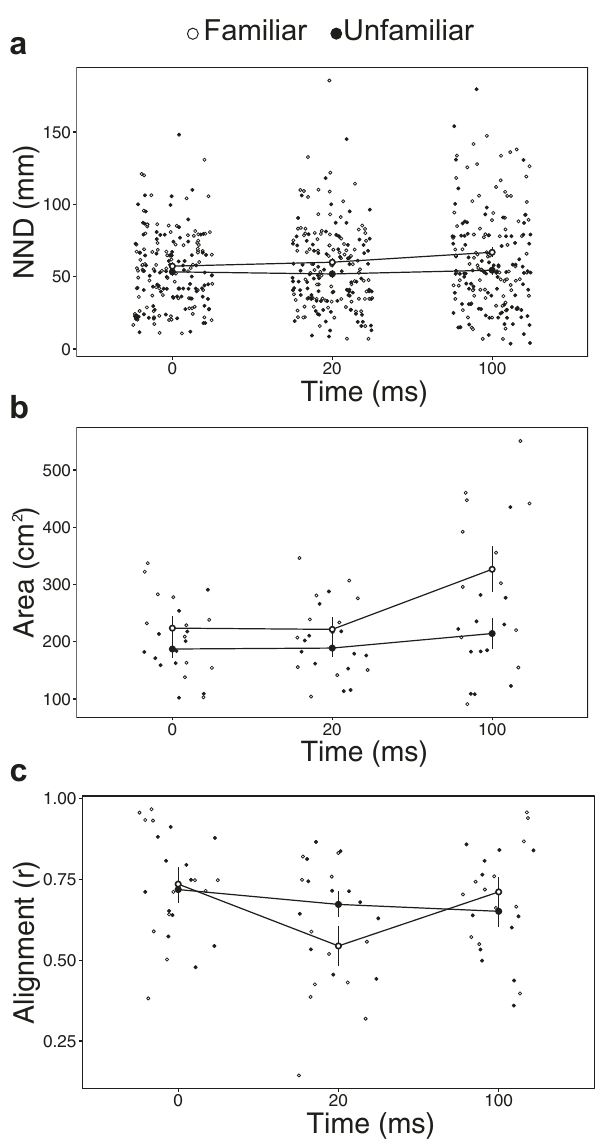
Fig. 5 Effect of familiarity on escape performance of fi sh schools ( Chromis viridis ). a Nearest neighbour distance (NND) denotes the distance to the closest neighbour (mm). b School area indicates the school ’ s horizontal spread (cm 2 ). c Alignment is a measure of the variation in the orientation of all school members. This variable is characterised by the length of the mean circular vector ( r ). Each larger dot represents the mean ± s.e., with small dots indicative of individual data points ( n = 24 schools, composed of 8 fi sh each).